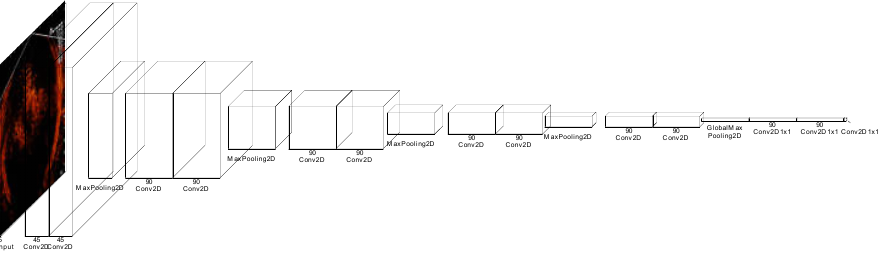
Figure 16. The neural network architecture for detecting fish-gathering frame.